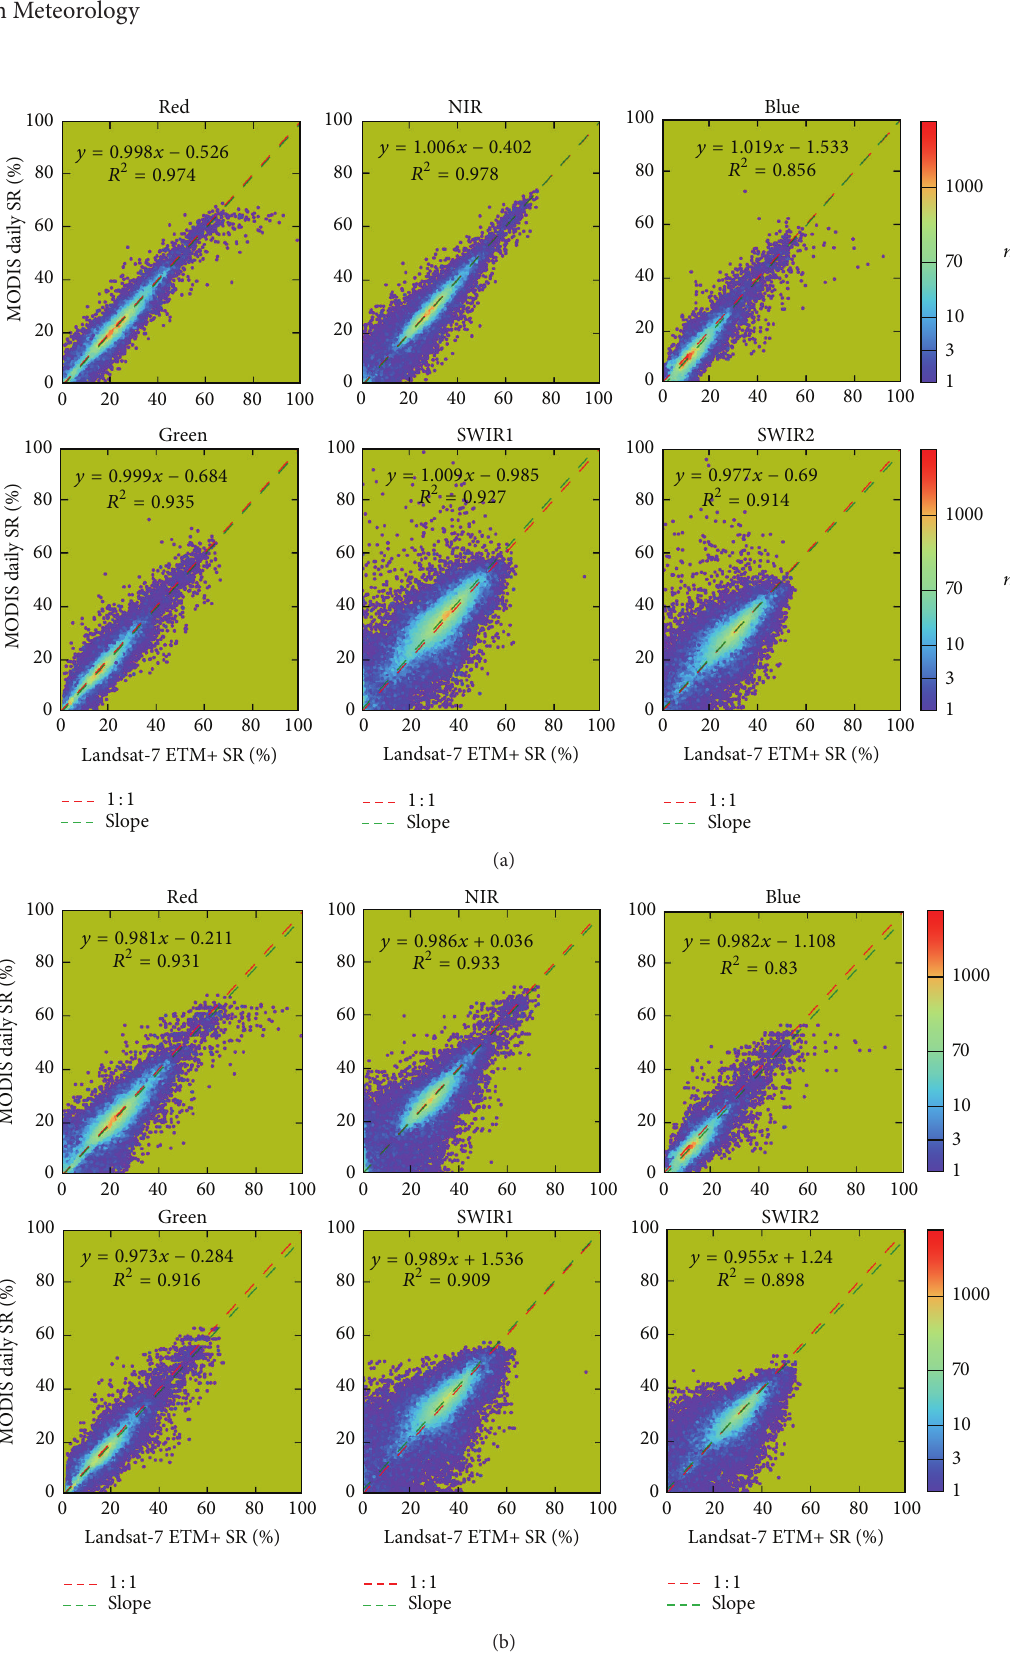
Figure 6: Density plots of comparison between Landsat-7 ETM+ aggregated to 250 m and MODIS 250 m (a) and 500 m